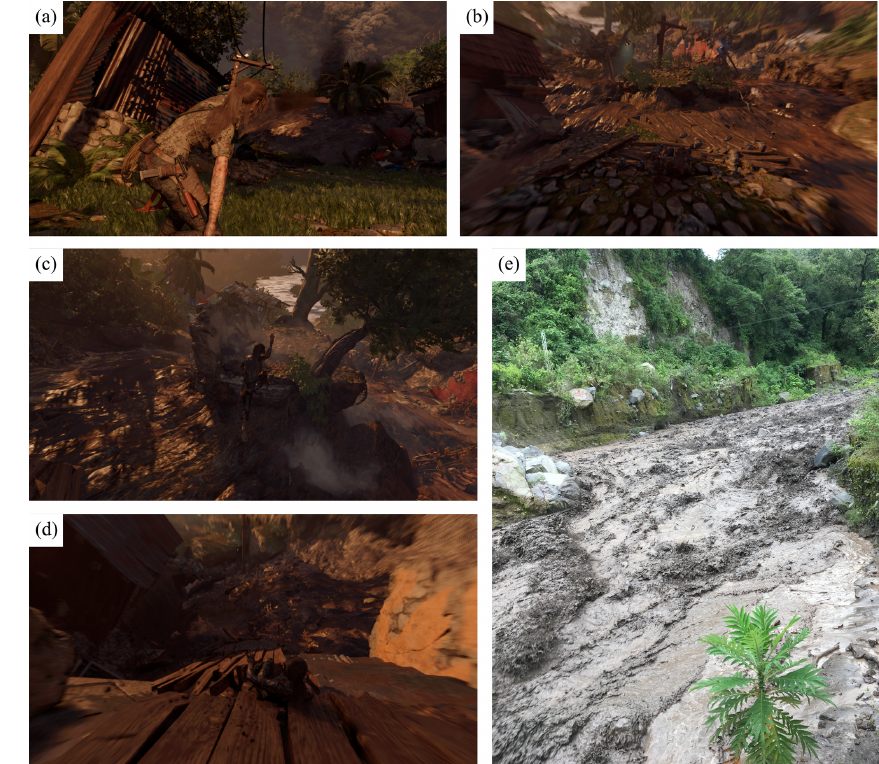
Figure 8. Lahar sequence in The Shadow of the Tomb Raider © Eidos-Montréal (2018; a–d ) compared to a still image of a lahar in full flow down a barranca at the base of Volcán de Colima, Mexico (Edward McGowan, 2018; e ).